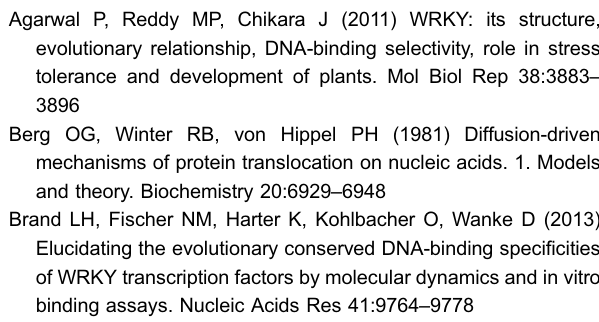
b Figure 2. Detailed protein-DNA interactions of AtWRKY-1N . (A) Structure-based sequence alignments of AtWRKY1-N, AtWRKY2-N, AtWRKY33-N and AtWRKY4-C based on AtWRKY1-N structure. The residues for recognizing DNA are marked by black triangles, and the sizes of the triangles correspond to the importance of the interacting residues. The highly conserved WRKYGQK sequence is coded as W 1 R 2 K 3 Y 4 G 5 Q 6 K 7 . ( B – E) The comparison of interacting details of amino acids and DNA bases between AtWRKY1-N and AtWRKY4-C. Their distances (Å) are shown next to. The green dashed lines indicate H-bonds and the yellow is hydrophobic interactions. (F) Schematic representation of the interactions of AtWRKY1-N, AtWRKY2-N and AtWRKY33-N with the consen- sus W-box DNA sequences. Interactions of amino acid residues with phosphate groups and nucleobases are shown as red dotted lines and solid lines, respectively. H-bonds are indicated by blue, and the apolar contacts are orange. (G) ITC experi- ments of AtWRKY1-N and the dsDNA containing the W-box motif and the mutated sequences. The full dsDNA sequences used in the ITC experiments were shown in Table S2, and the af fi nity comparation was summarized in Table S3. (H) The EMSA results of AtWRKY1 101 − 339 (residues 101 – 339, compris- ing both WRKY domains) binding to W-box DNA. Molar ratios of protein-to-DNA are shown at the top of each gel as the molar concentration of protein increases gradually. The DNA sequence is shown in Table S2. The fi rst band indicates both WRKY domains bind to DNA at the same time whereas the second band denotes only one WRKY domain participates in DNA binding. (I) ITC experiments were performed by titrating 0.11 mmol/L AtWRKY1 101 − 339 into 0.026 mmol/L W-box DNA. The number of N equals 0.5 indicating the two WRKY domains of AtWRKY1 101 − 339 (residues 101 – 339) can interact with DNA at the same time. The DNA sequence used in the ITC experiment is shown in Table